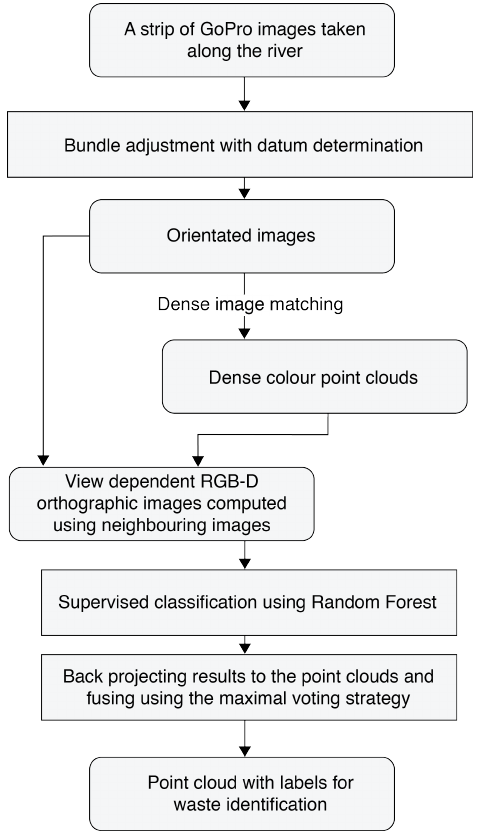
Figure 1: Flowchart of the sequential processing